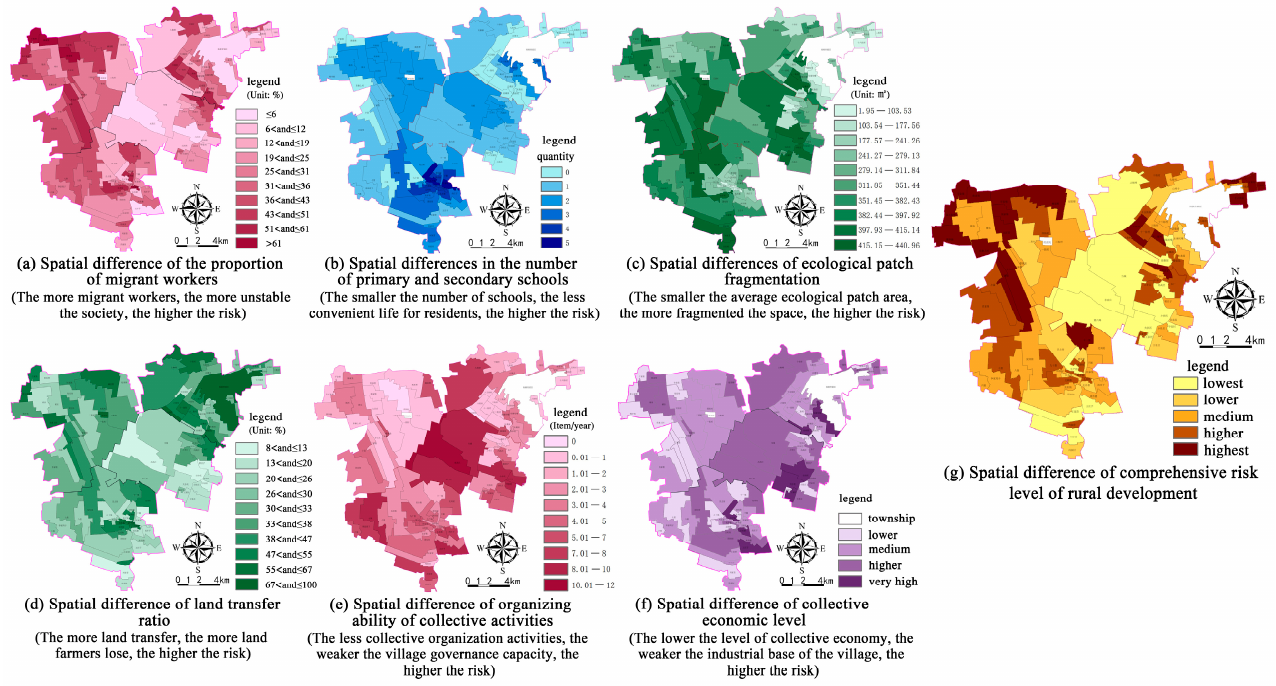
Figure 7. Spatial differentiation of rural systemic risk factors in the western suburbs of Tianjin (source: self-drawn).